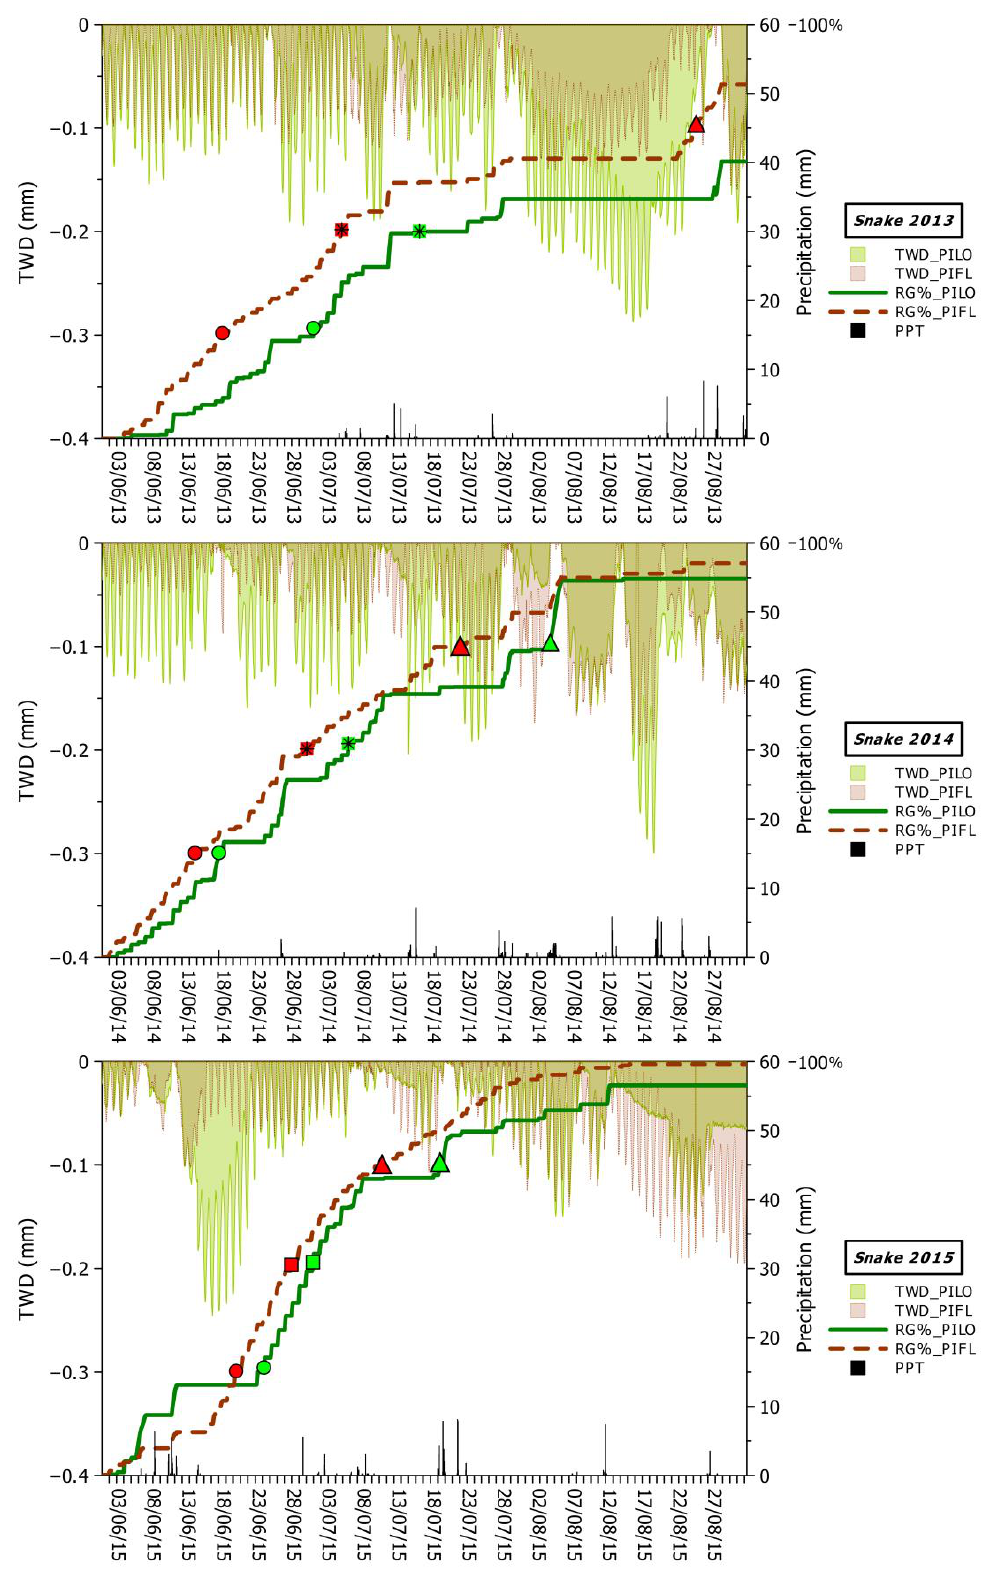
Figure 5. Tree water deficit (TWD) and real growth (RG) time series in 2013 – 2015 for PILO and PIFL (Snake Range). Symbols represent quartiles of real growth observed between June and September (circles = 25%; squares = 50%; triangles = 75%). Vertical bars represent total hourly precipitation. (Right y axes also represent 100% of RG). For a definition of TWD and RG see main text. Species codes are the same as in the Figure 2 caption.